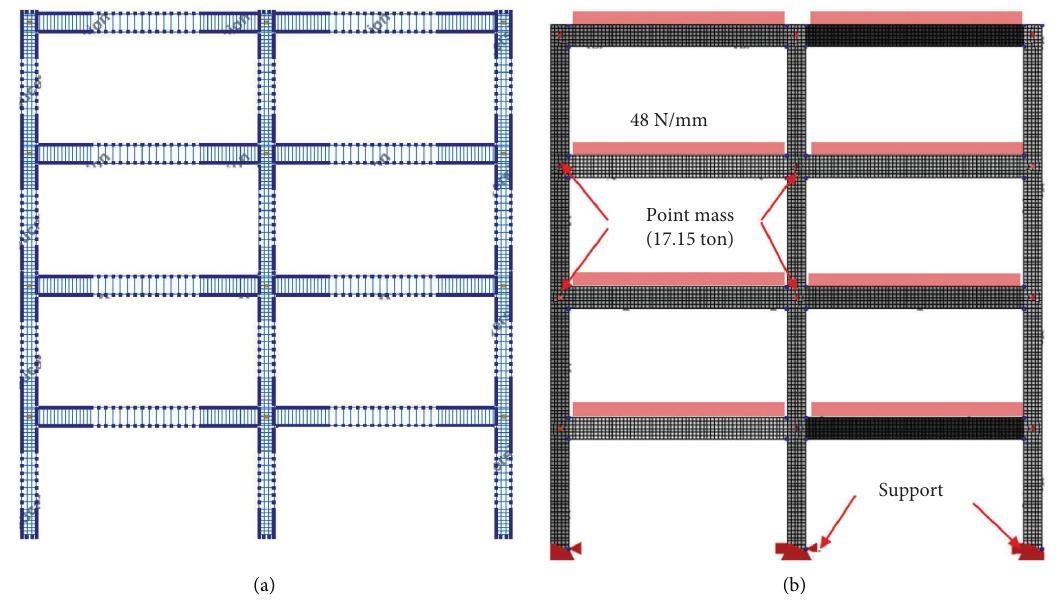
Figure 6: FE mesh of the frame structure. (a) Reinforcement elements. (b) Concrete elements.